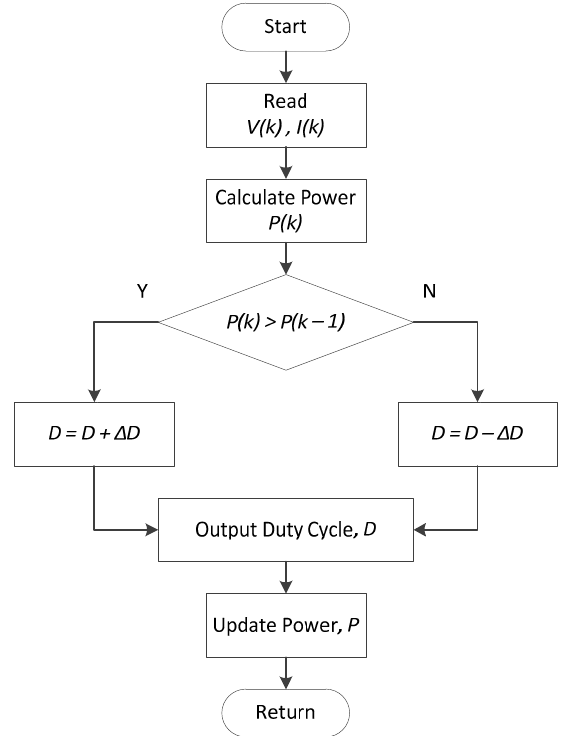
Figure 7. Flow diagram of HC.